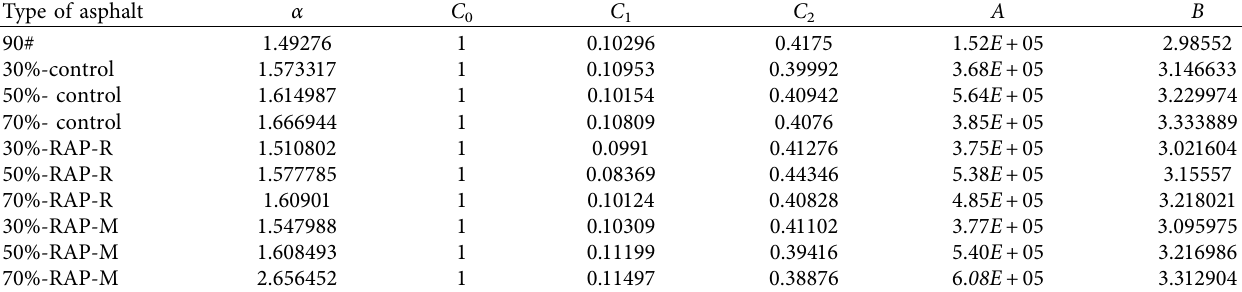
Table 3: Resulting parameters of the VECD